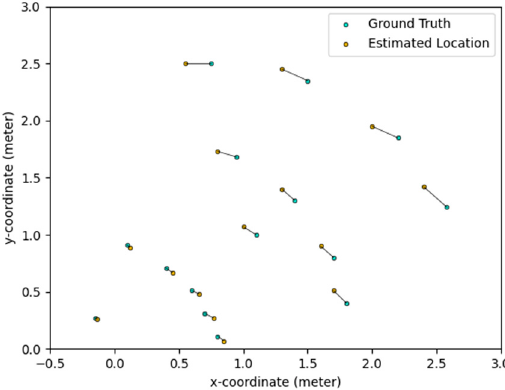
Figure 7. Localization of non-compliant groups. The above plot shows the non-compliant groups being localized with respect to the Cartesian coordinate system fixed to the robot. The maximum error observed between the ground truth and the estimated location was 0.24 m and the average error observed between them was approximately equal to 0.12 m. The detection and localization of the non-compliant groups during two different experiments performed with the proposed system and navigation of the robot to these groups are shown in Figure